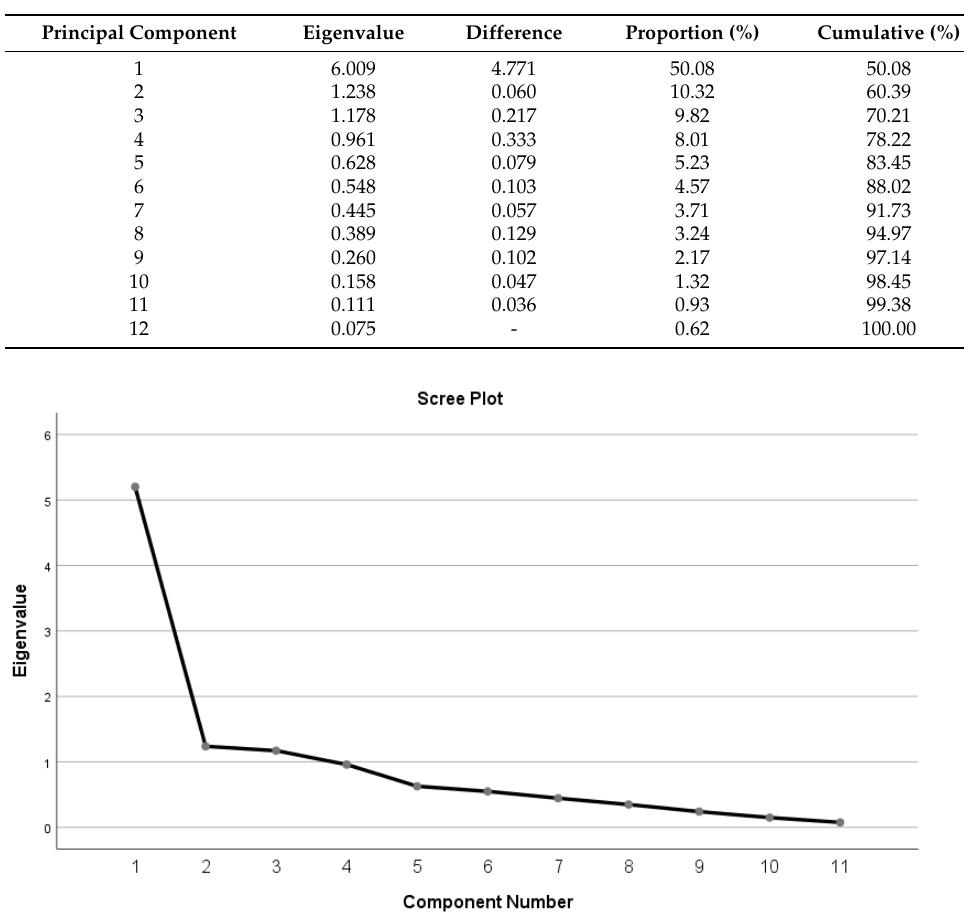
Figure 2. Scree plot (explained variance of each principal component) calculated for the factors.